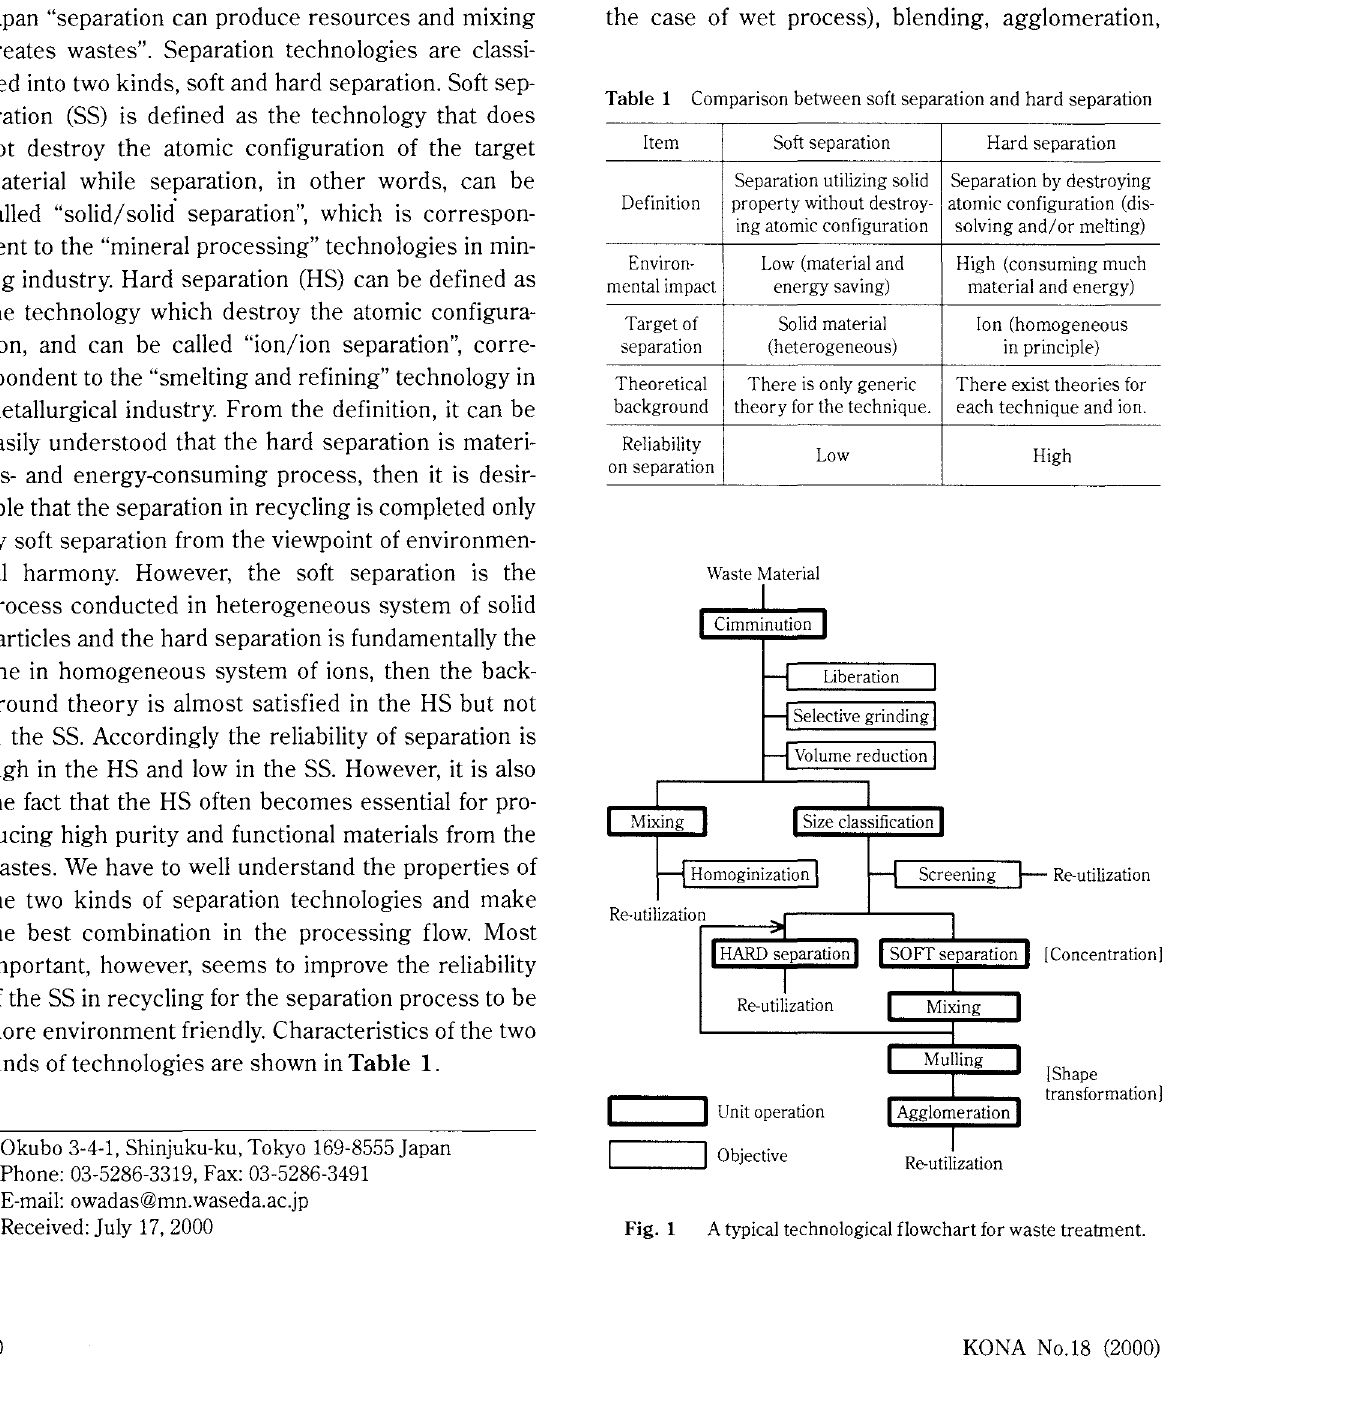
Table 1 Comparison between soft separation and hard separation